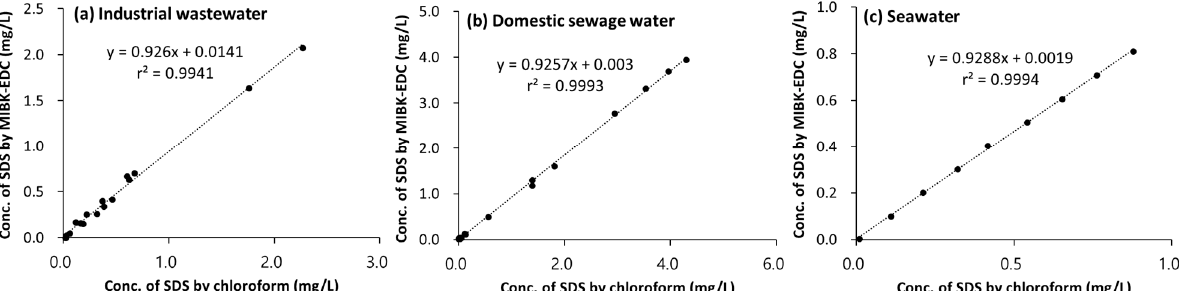
Figure 2. Sensitivity analysis between MIBK-DCE and chloroform method for the anionic surfac- tants in ( a ) industrial wastewater ( n = 17), ( b ) domestic sewage water ( n = 24), and ( c ) seawater ( n =